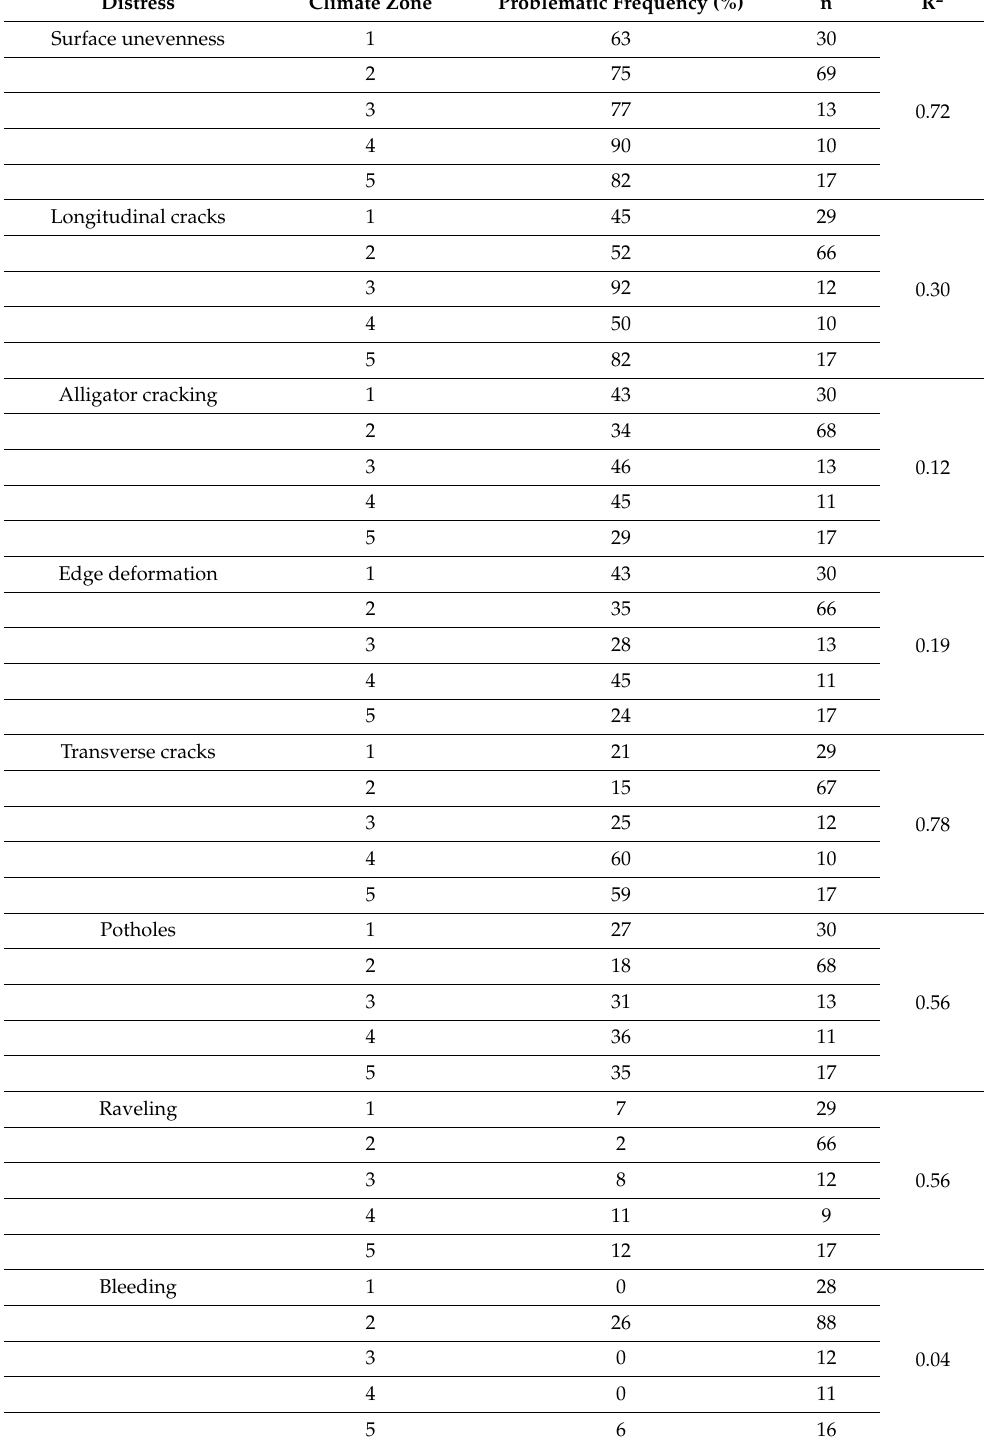
Table A1. The table shows the correlation between the stated distress modes and the problematic frequency with respect to climate zones in TRVK Väg . Bold R 2 values represent a strong correlation, as shown in Figure